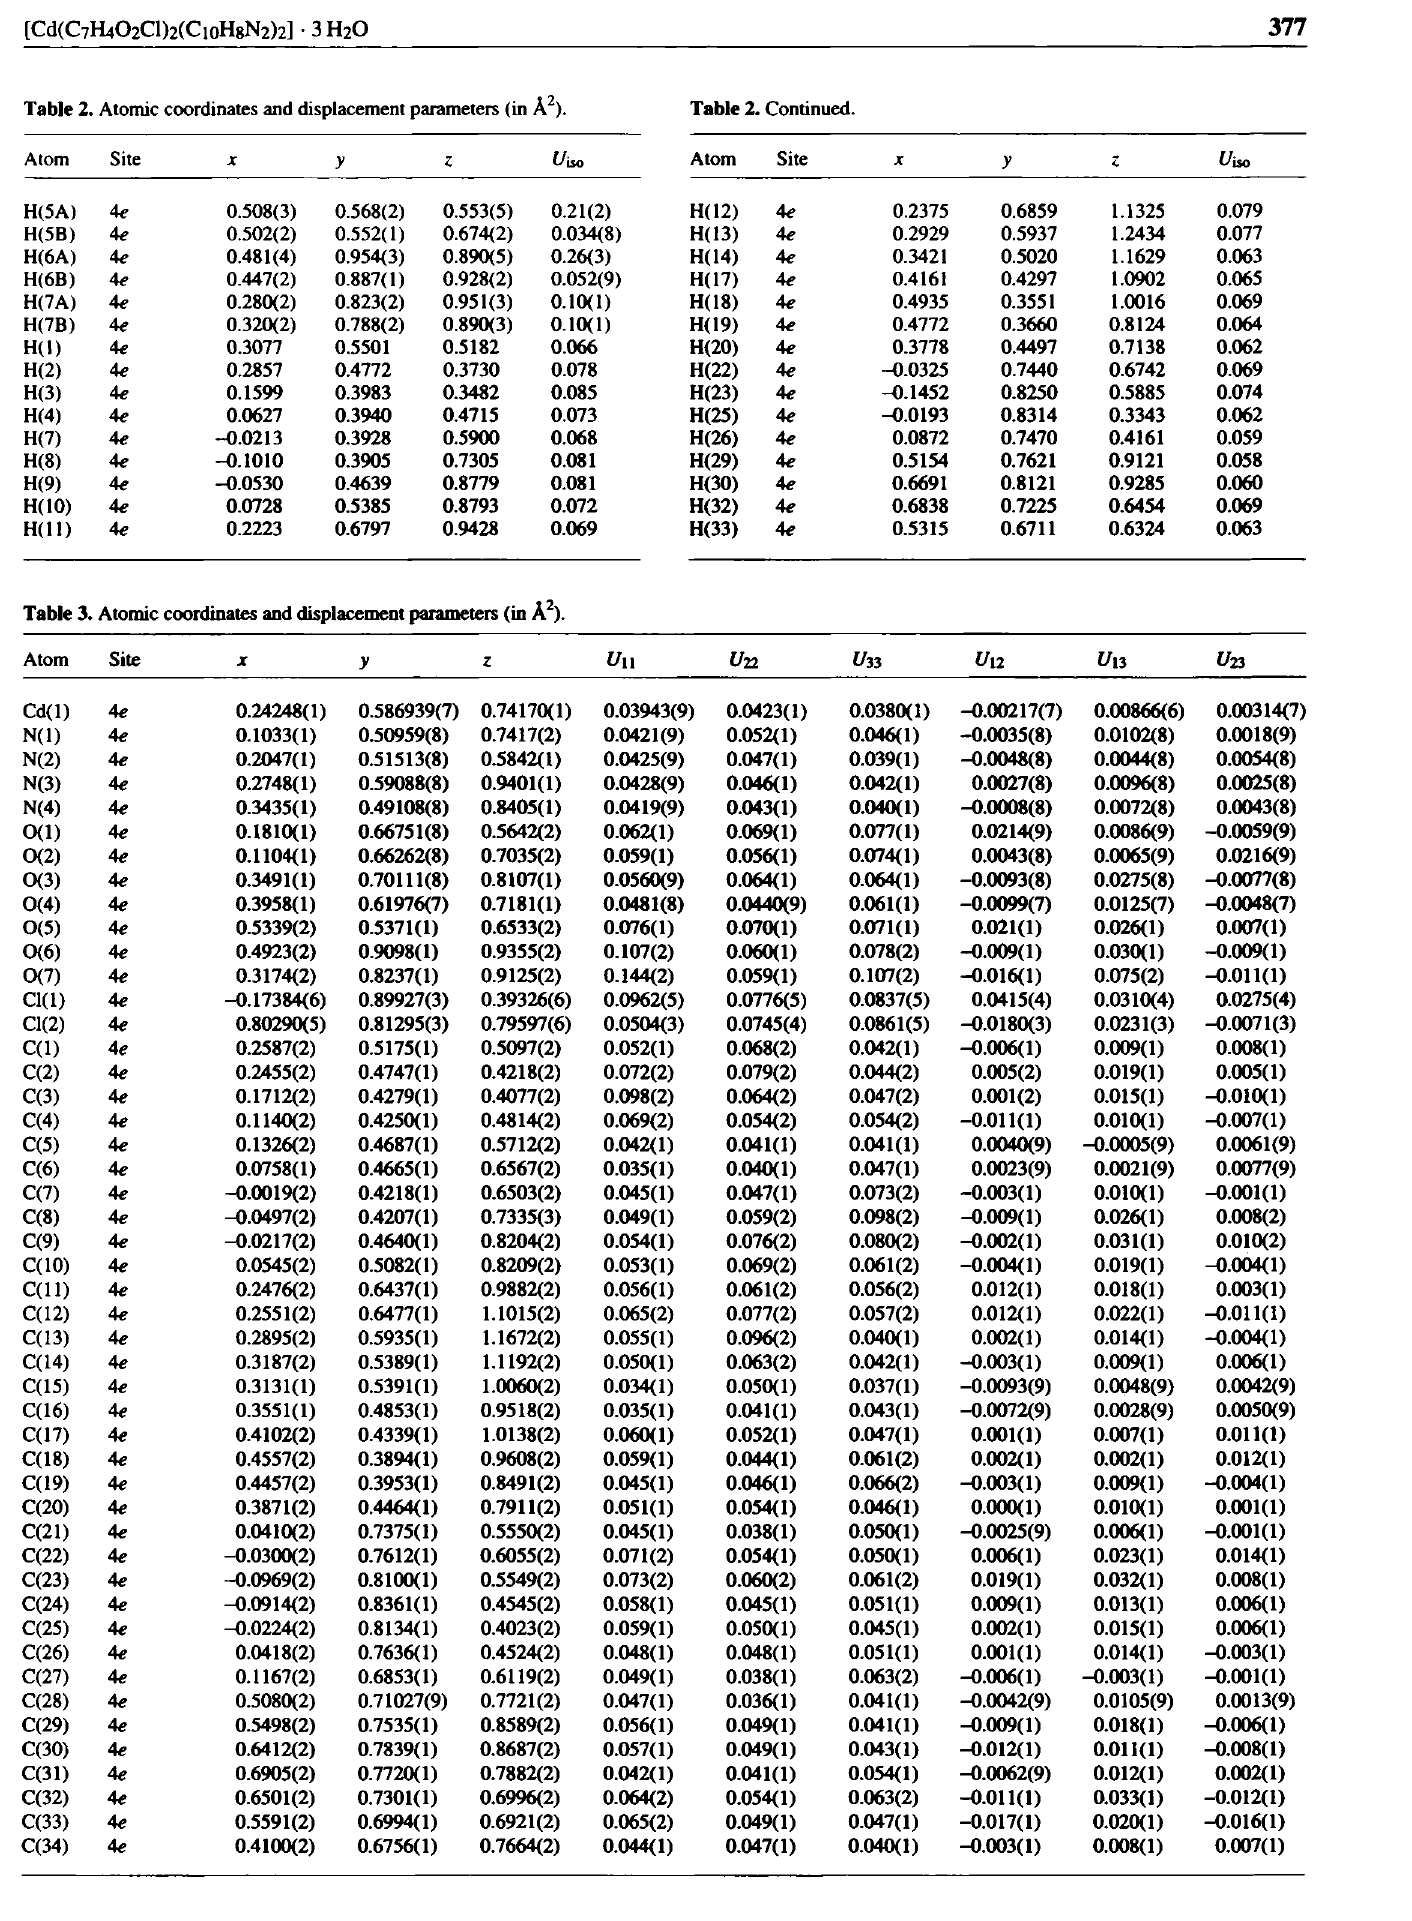
Table 2. Atomic coordinates and displacement parameters (in Ä 2 ). Table 2. Continued.